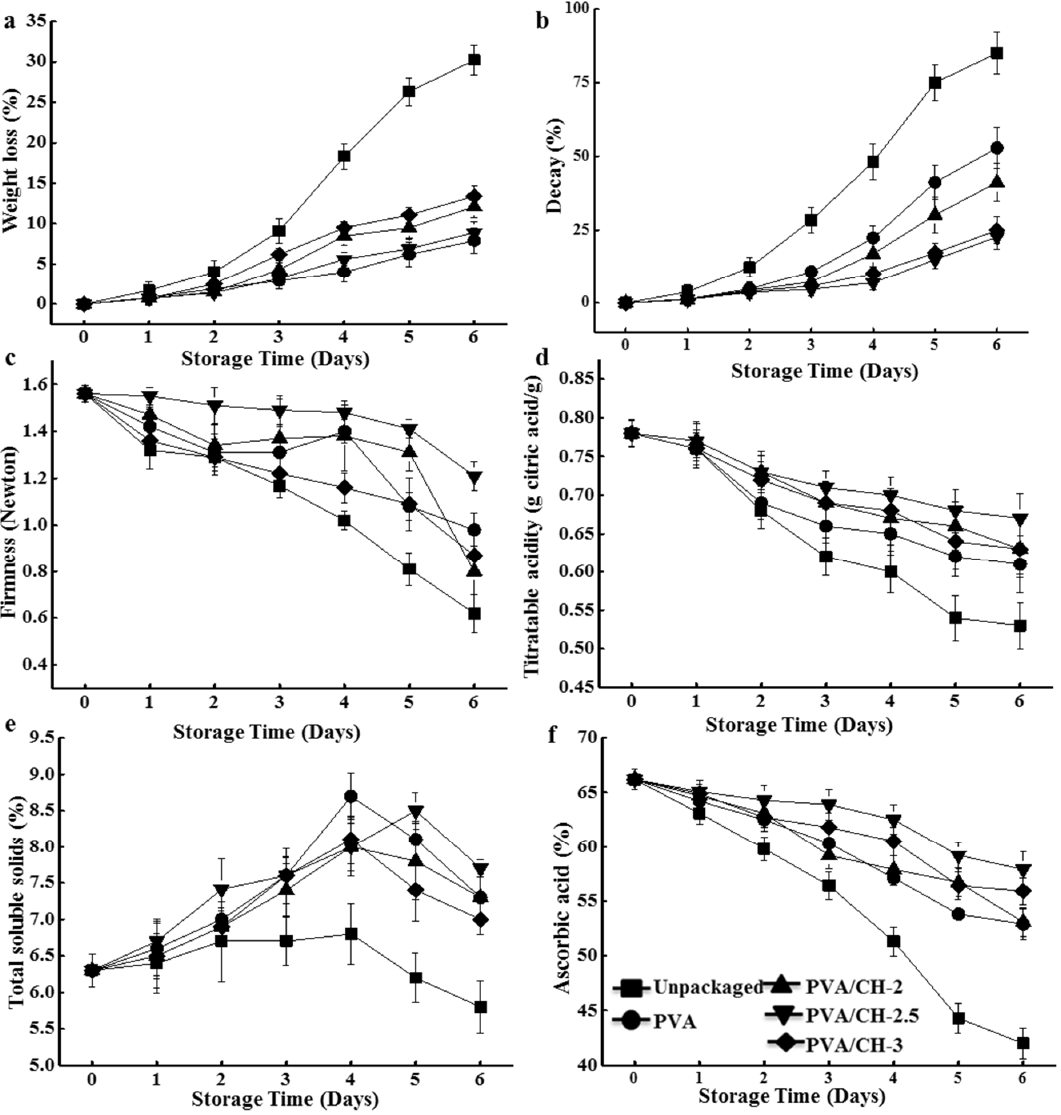
Figure 3. Effect of unpackaged PVA and different PVA/CH films on the ( a ) weight loss, ( b ) decay, ( c ) firmness, ( d ) titratable acid, ( e ) total soluble solids and ( f ) ascorbic acid quality parameters of strawberries during storage times.